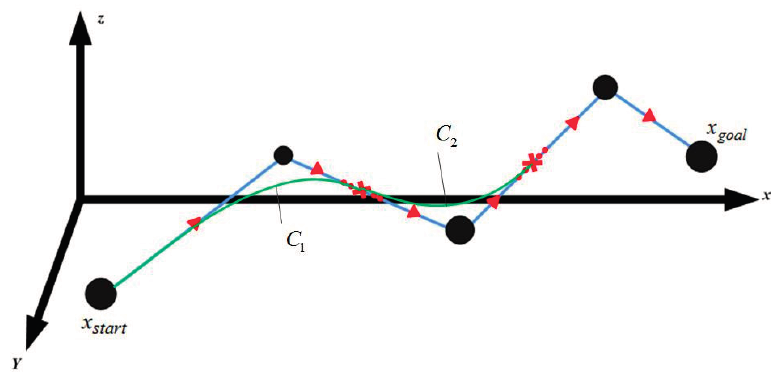
Figure 8. Result of the eighth-order Bezier curve C 2 constituted by the nodes { 2 N 0 , 2 N 1 , l , 2 N 8 }.